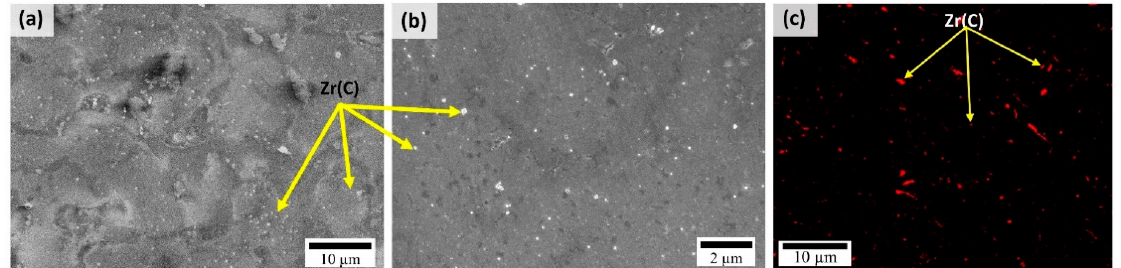
Figure 9. ( a , b ) SEM secondary electron micrographs of Fe-5 vol.% sintered samples produced by mechanochemical dispersion technique revealing the NP distribution (as the bright features), and ( c ) EDS elemental map of the Zr signal produced from ZrC particles.